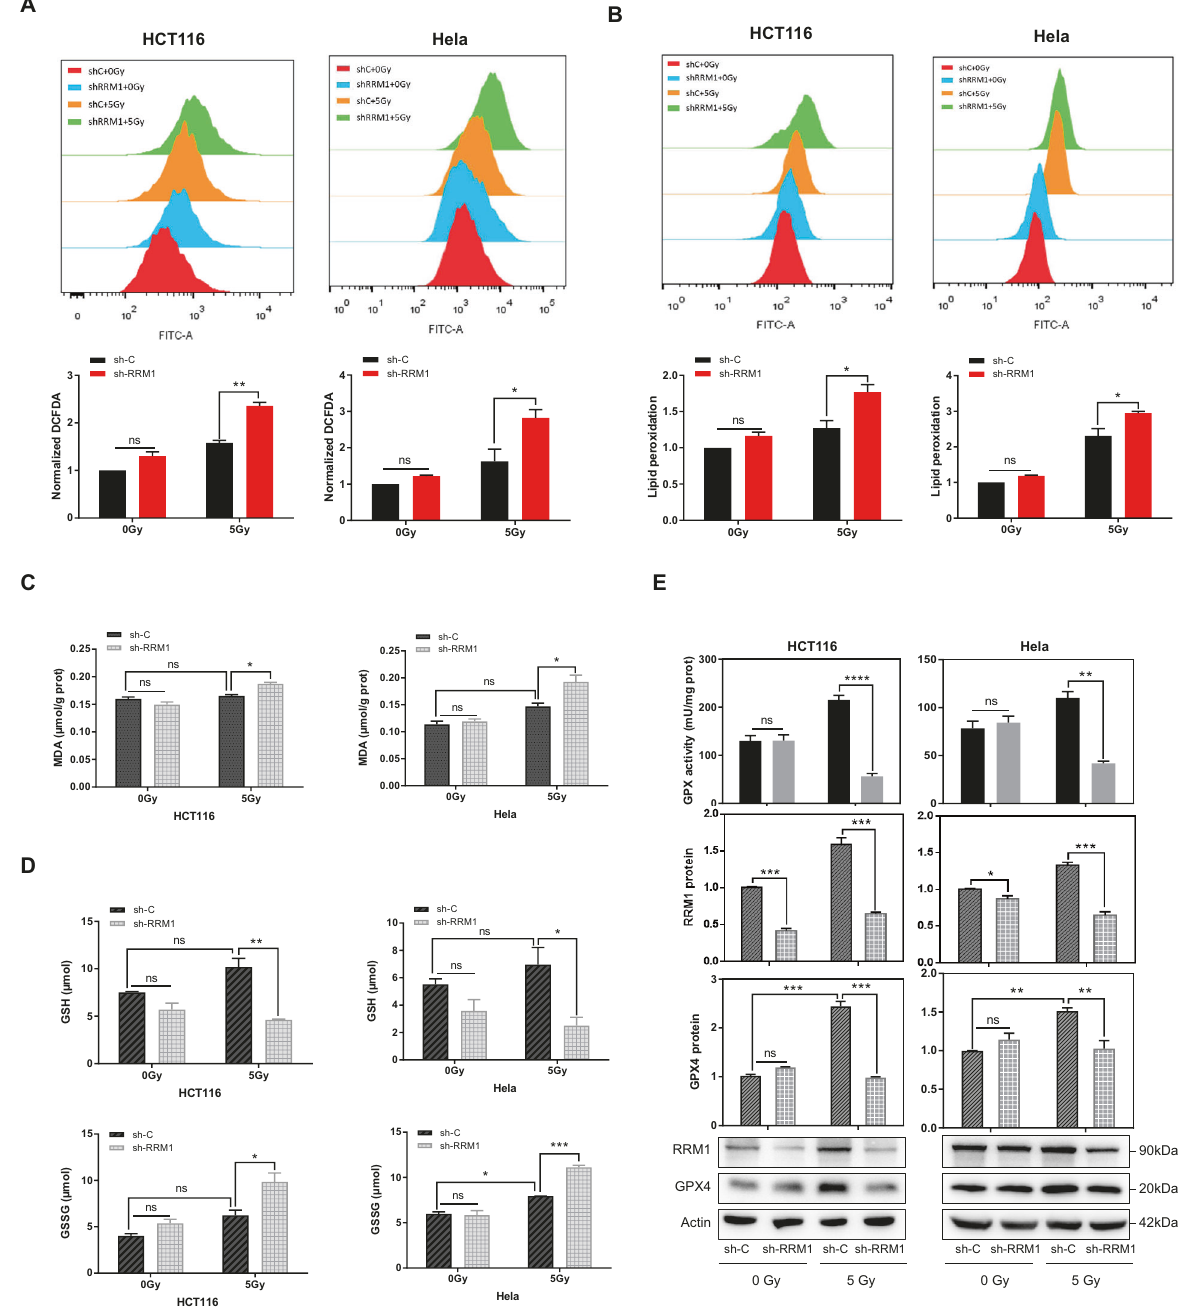
Fig. 2 Target RRM1 promotes IR-induced ferroptosis. A , B Assessment of total ROS levels ( A : DCFDA staining) or lipid peroxidation ( B : C11- BODIPY staining) in RRM1 knockdown cells after radiation. C Knockdown of RRM1 increased radiation-induced MDA production. D The levels of GSH and GSSG were assayed in RRM1 knockdown cells 24 h after 5 Gy γ -ray. E Lower GPX activity and GPX4 expression were measured in RRM1 knockdown cells 24 h after 5 Gy γ -ray.